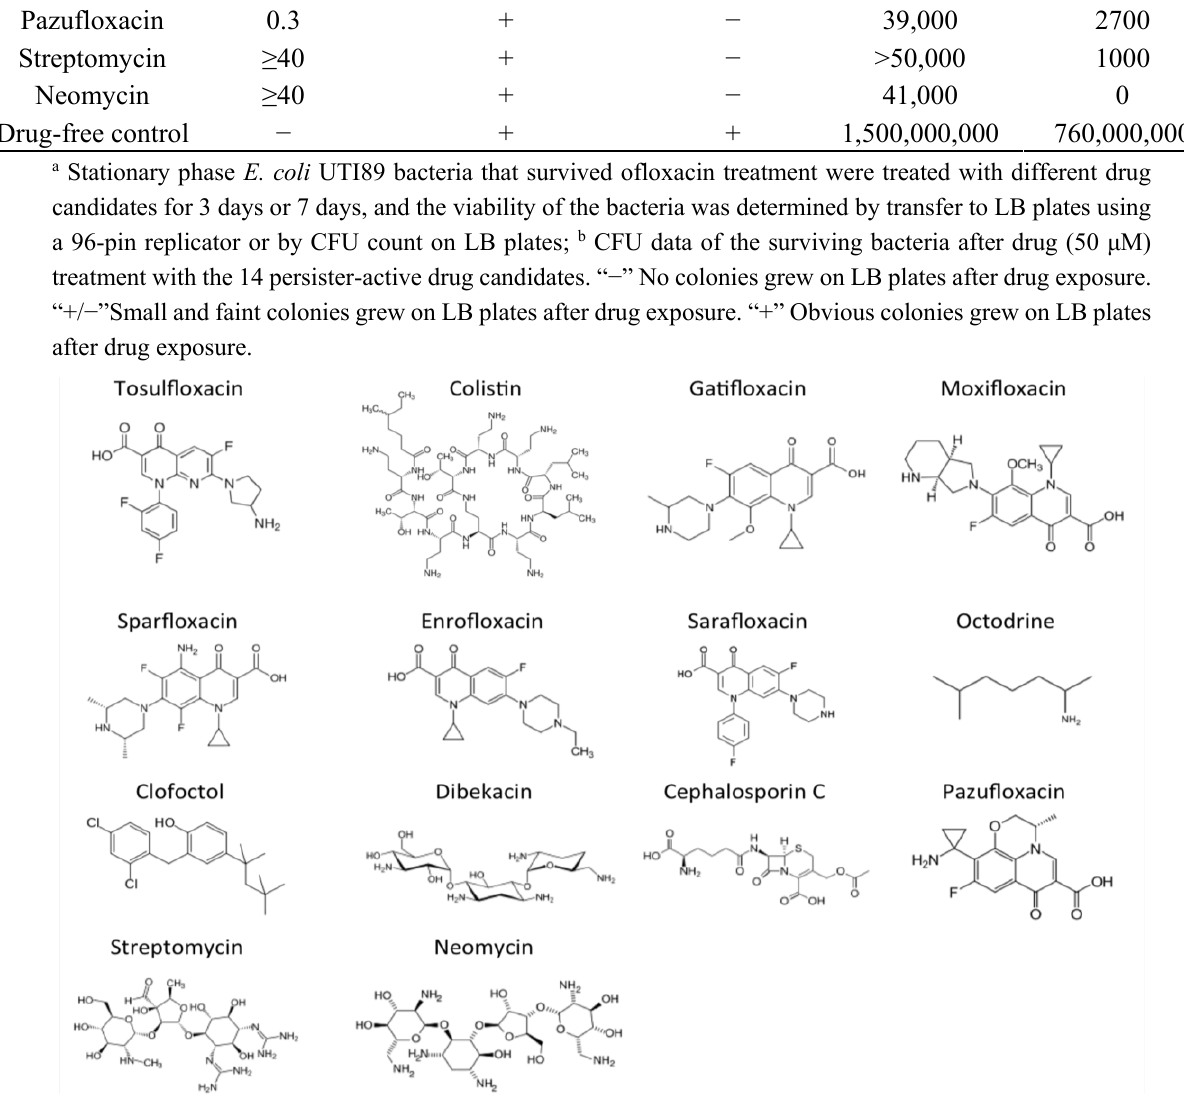
Figure 1. Structures of the 14 drug candidates with activity against E. coli UTI89